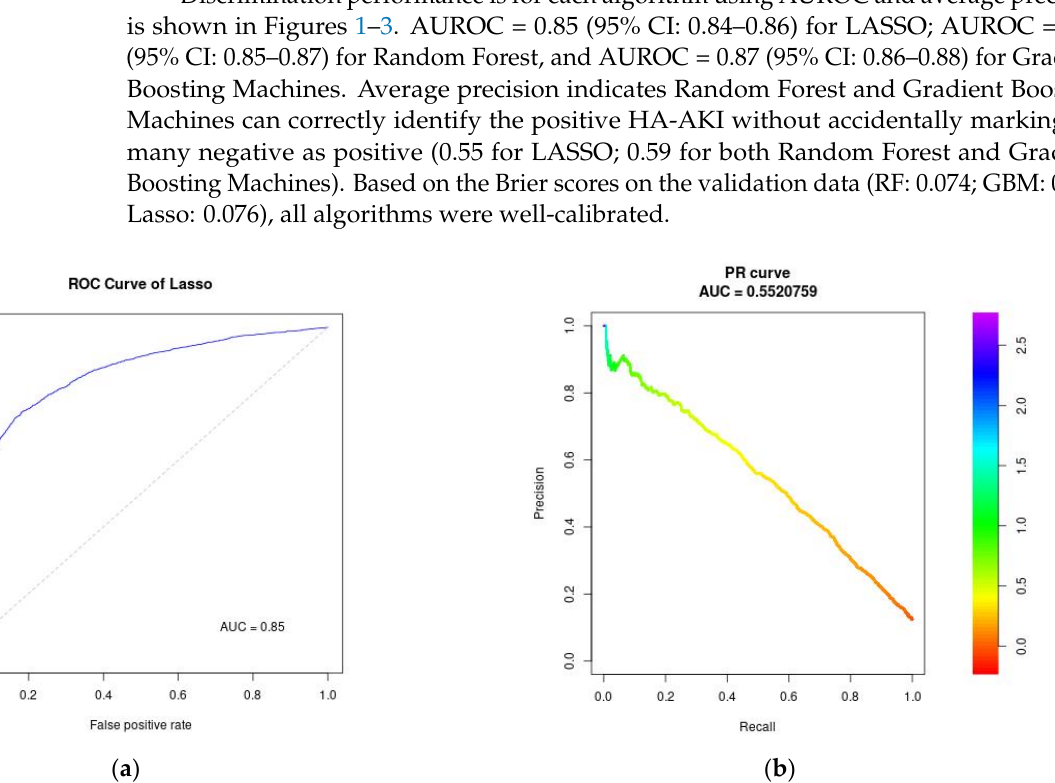
Figure 1. Performance evaluation for LASSO ( a ) Receiver Operating Characteristic (ROC) curve; ( b ) Precision-Recall (PR) curve. AUC: Area under the curve